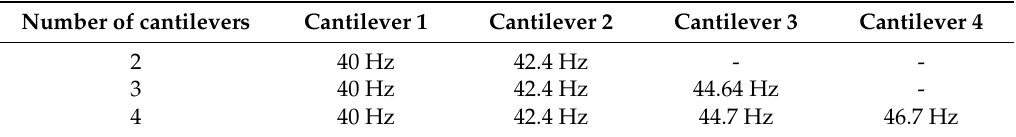
Table 2. The best theoretical arrangement to achieve the maximum theoretical bandwidth.